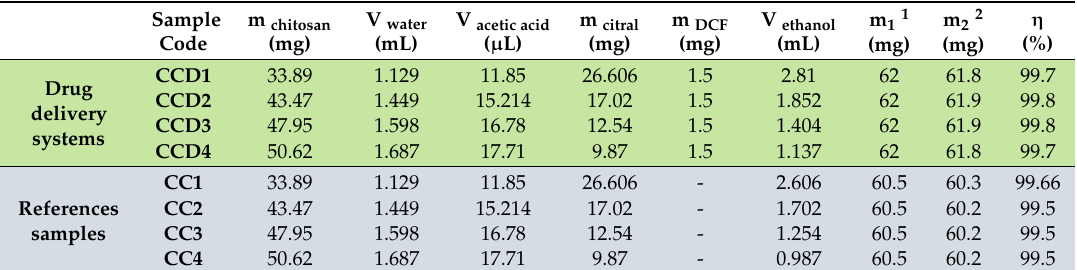
Table 1. The composition of the drug delivery systems ( CCD1-CCD4 ) and the reference hydrogels ( CC1-CC4